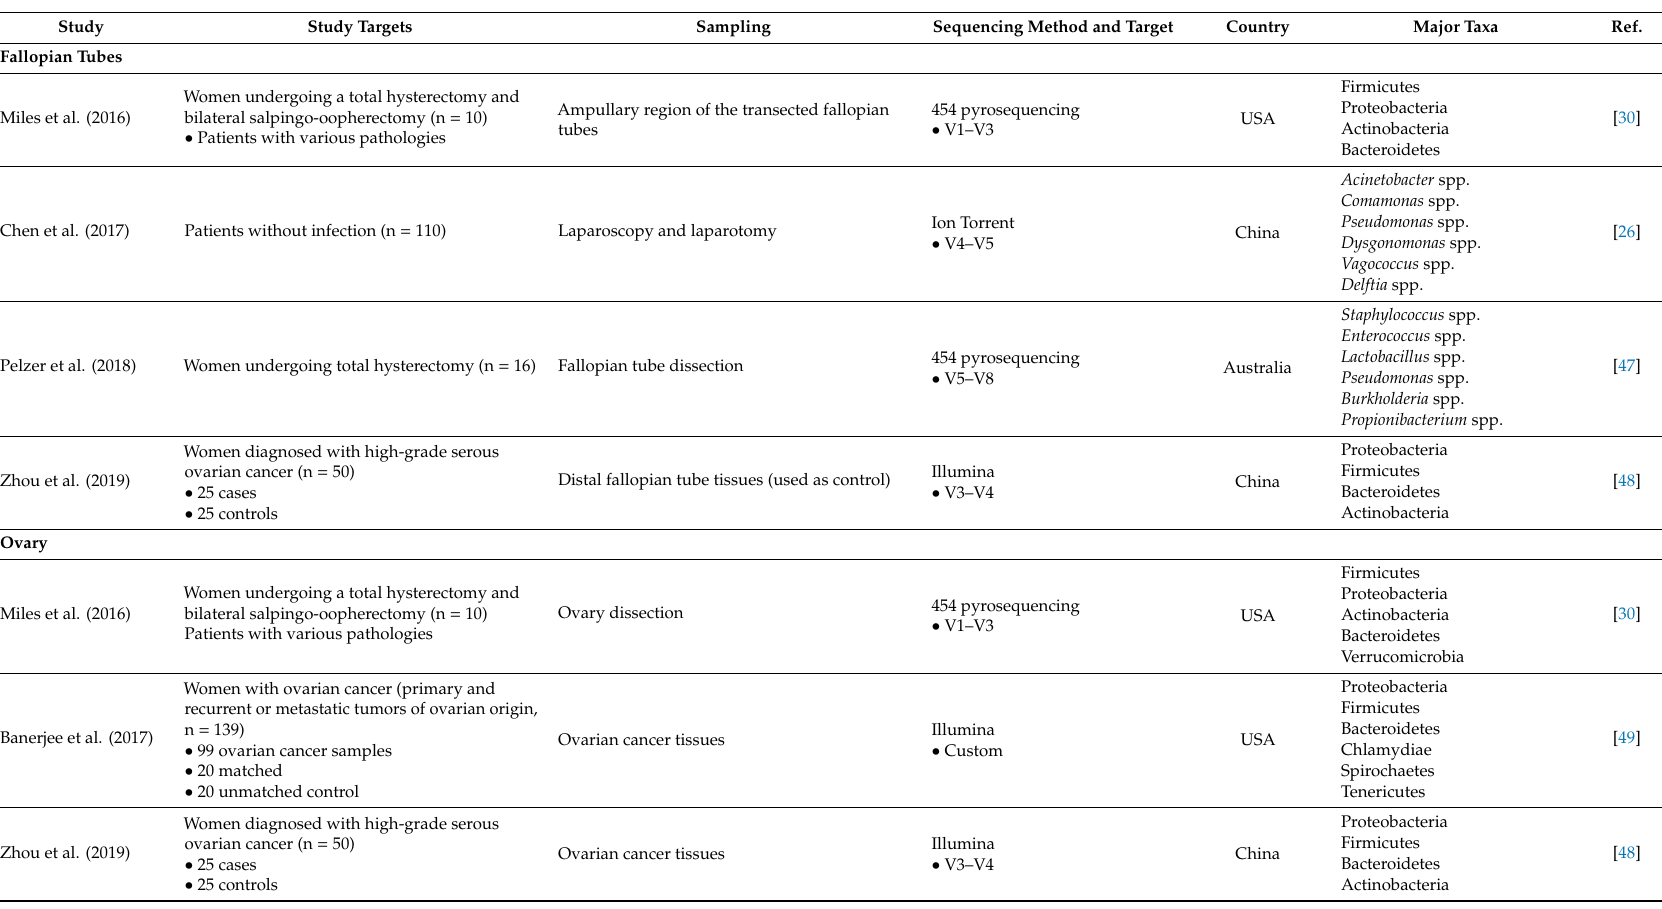
Table 3. Metagenomic studies performed on non-endometrial samples of the female